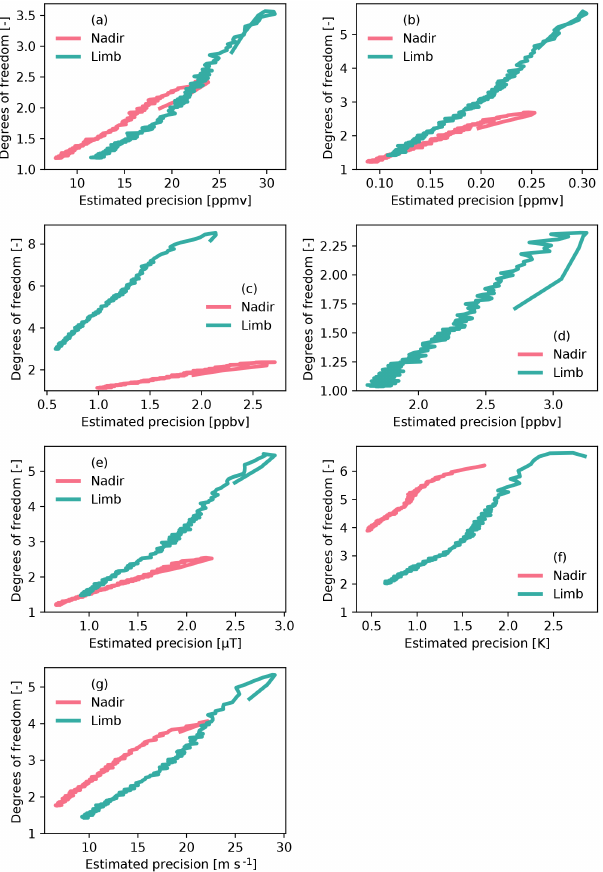
Figure 8. Estimated precision versus degrees of freedom (DOFs) by increasing the correlation distance all the way to 1000km (not shown). Panel (a) is for molecular oxygen. Panel (b) is for gaseous water. Panel (c) is for hydrogen peroxide. Panel (d) is for ozone. Panel (e) is for the magnetic field strength. Panel (f) is for the tem- perature. Panel (g) is for the wind speed. The legends indicate the observation strategy as used for Figs. 5 or 7. The estimated preci- sions are the mean over the range of max ( r ) > 0 . 8, so the ozone panel lacks a line for nadir-staring mode since it is never sensitive at the a priori standard deviations presented in the subsection on er- ror analysis. Note that the solid line goes from shorter correlation distance tending towards higher degrees of freedom to longer cor- relation distances tending towards lower degrees of freedom. The “hook” that appears on the right-hand side of some of the lines is from correlation distances much shorter than the antenna